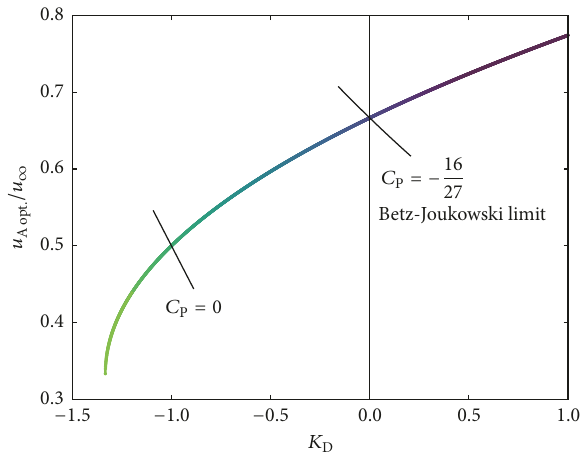
/𝑢 ≡ ∞ Aopt . 𝐾 . The curve D